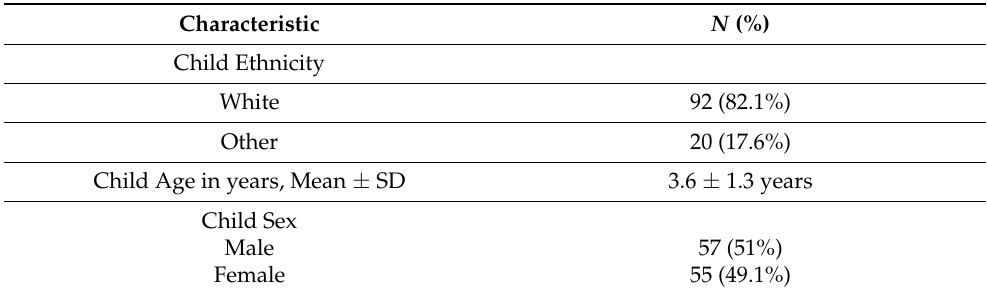
Table 2. Characteristics of children ( n = 112) participating in Guelph Family Health Study pilot studies at